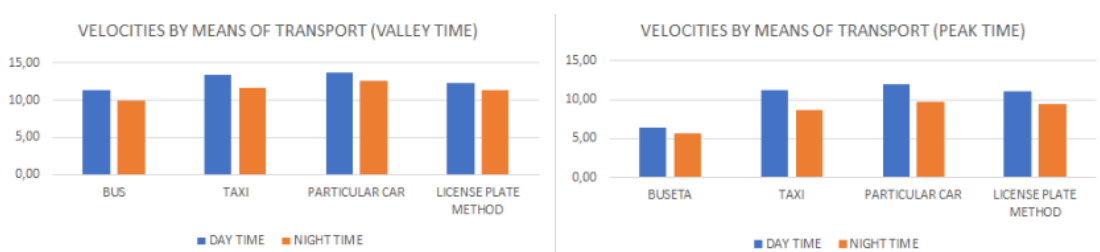
Figure 5: Velocities according to the type of vehicles (means of transport) at section 1 of the Avenue under study